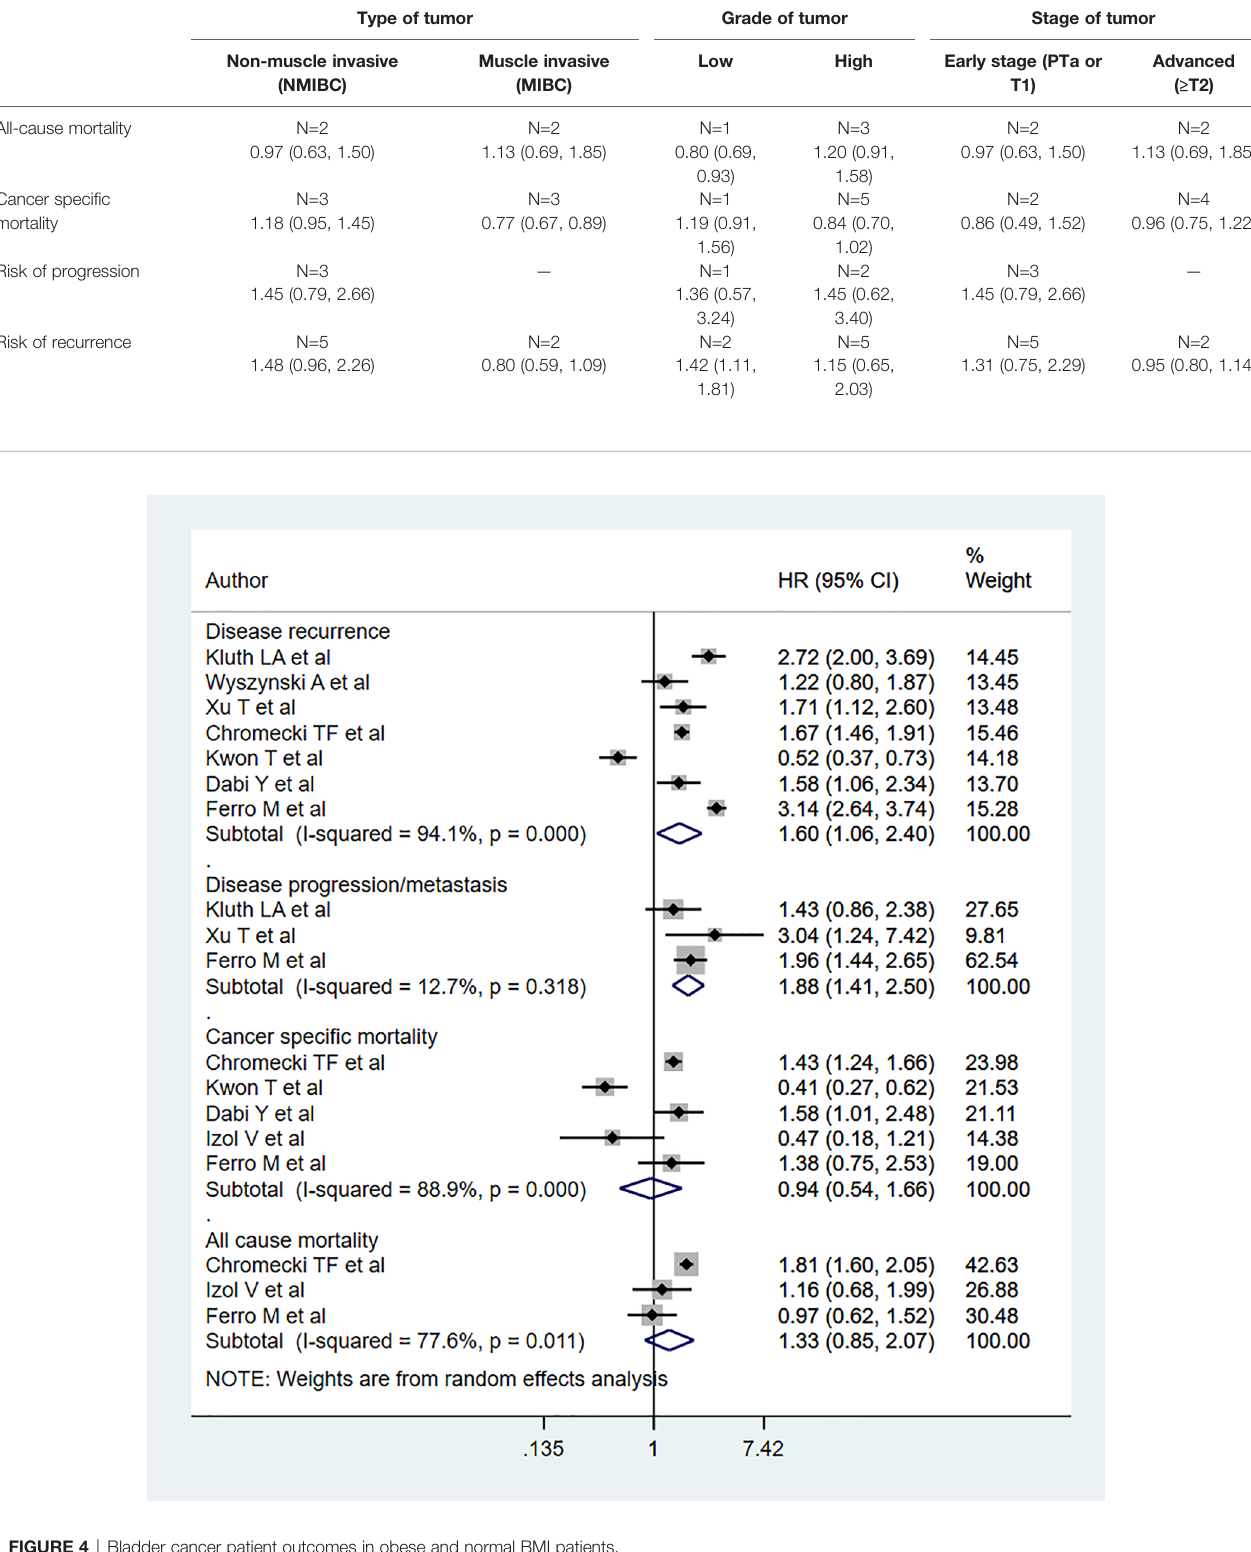
FIGURE 4 | Bladder cancer patient outcomes in obese and normal BMI